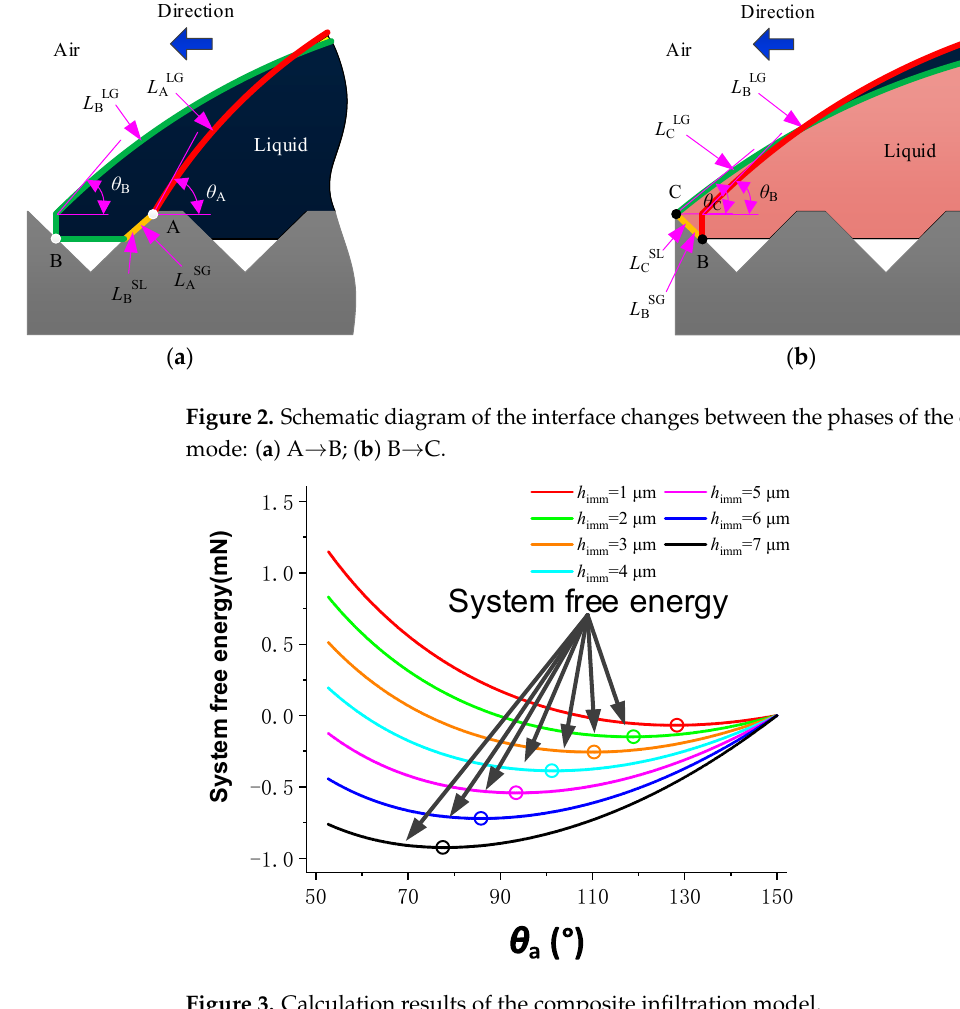
F of the three-phase contact point extending B C